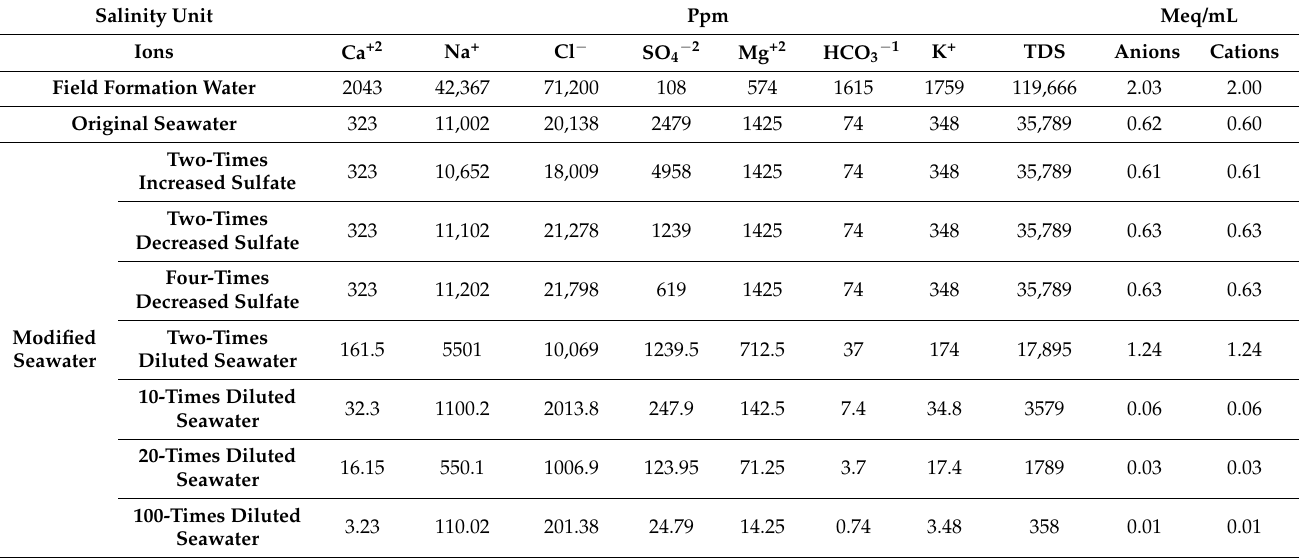
Table 7. Compositions of different waters with concentration of various